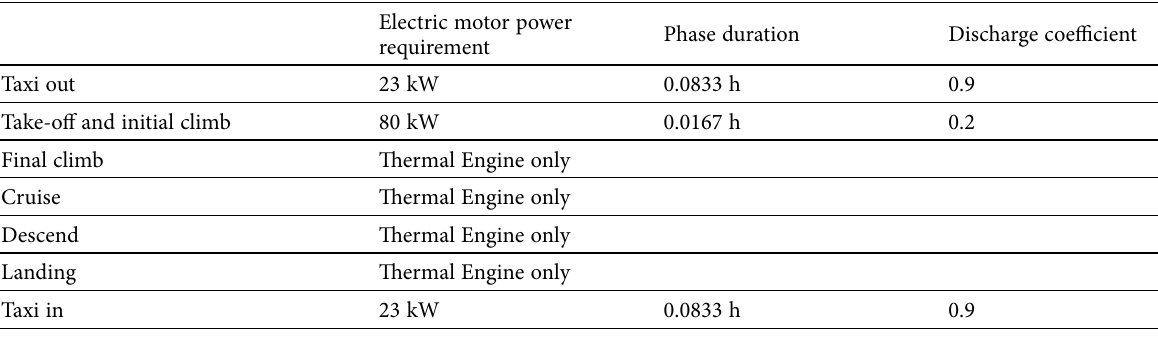
Table 4. Inputs required for the storage system sizing